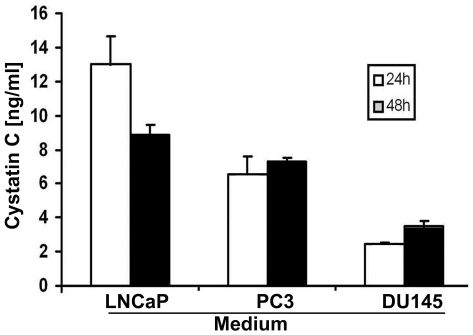
Cystatin C is expressed in the media of prostatic cells lines.ELISA assay of supernatants from three different prostate cancer cells lines, which were plated 24 h or 48 h before experiment was carried out. Data are shown as average of triplicates±SD for 3 experiments.